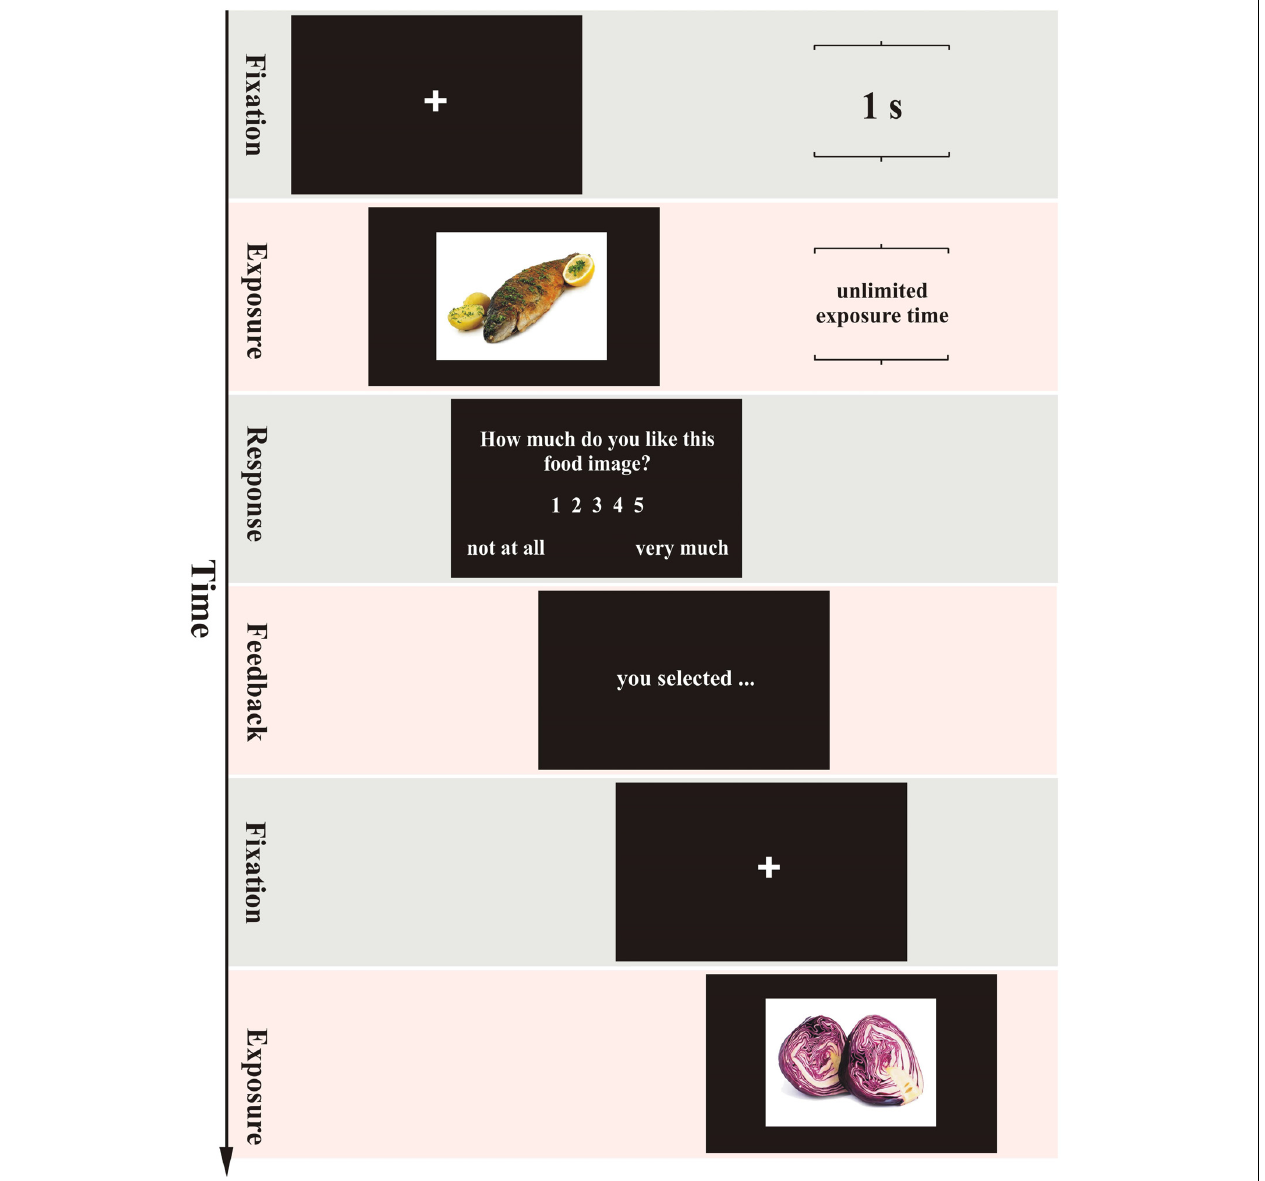
FIGURE 1 | The trial structure in the self-paced non-exclusive evaluation. The structure was the same in the three other evaluation tasks except for the following critical differences. The duration of the exposure frame (second row) was either self-paced or time-controlled. In the self-paced evaluation tasks, the subject had to press the space bar to proceed to the response frame. In the time-controlled evaluation tasks, the response frame replaced the exposure frame automatically after a computer-generated duration. In the exclusive evaluation tasks, the response frame presented the question, “Would you like to add this image to your food basket?” and gave the options “Yes” or “No.” In the exclusive evaluation tasks, the feedback frame indicated the number of items added to the basket so